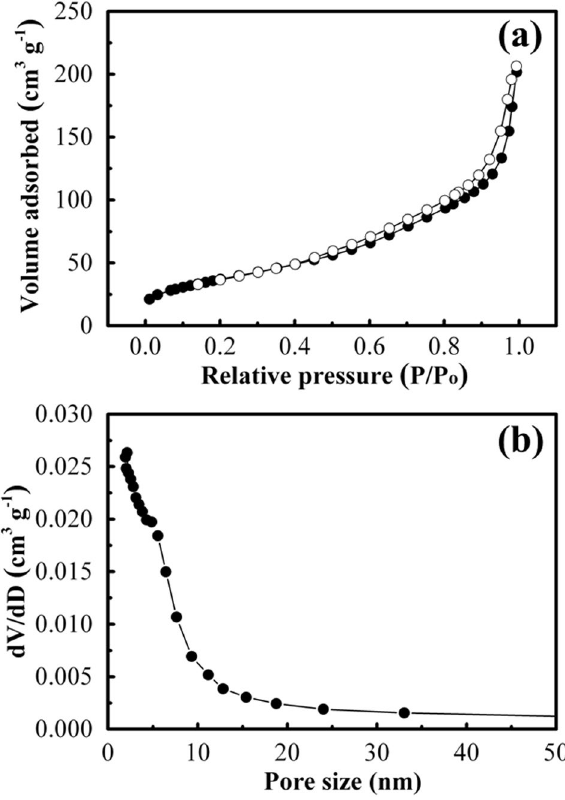
Figure 4. ( a ) N 2 adsorption-desorption isotherms of TiO 2 @Nb 2 O 5 composites and ( b ) the corresponding pore size distributions calculated using the BJH